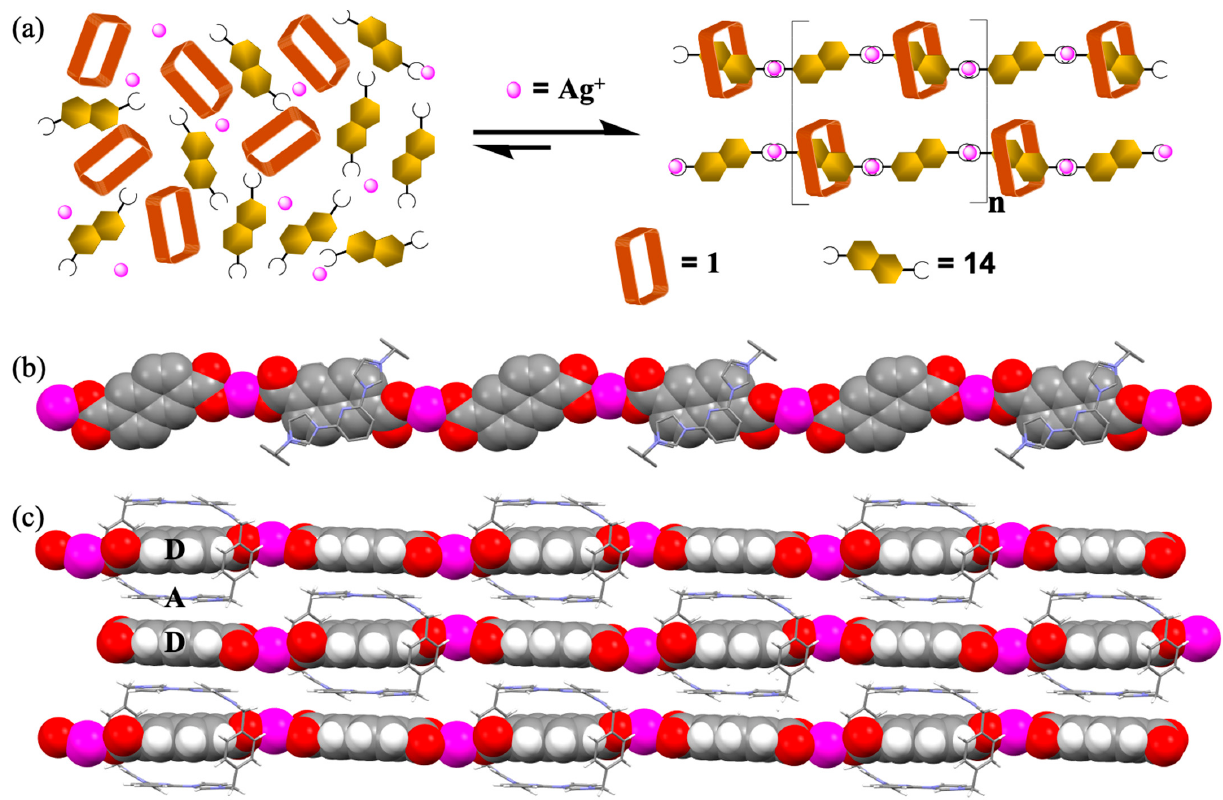
Figure 4. ( a ) Assembly of a silver-linked polypseudorotaxane constructed from TxSB 1 , Ag(I), and the 2,6-naphthalenedicarboxylate dianion. ( b ) Top and ( c ) side views of the silver-linked polypseudorotaxane chain seen in the solid state. A and D stand for acceptor and donor, respectively. Note: Compound numbers are provided in Table 1. Modified with permission from a figure that first appeared in ref [51]. Copyright 2011 American Chemical Society.